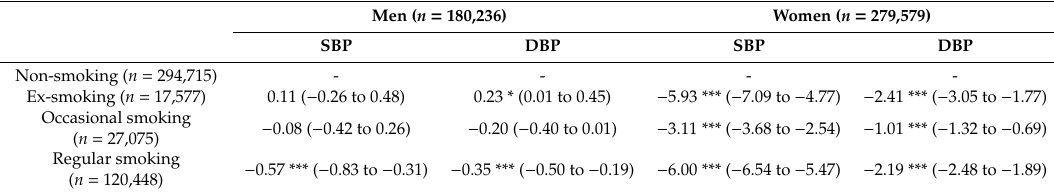
Table 2. Multivariable a linear regression coe ffi cients (95% confidence interval) for systolic and diastolic blood pressure levels according to baseline smoking status.